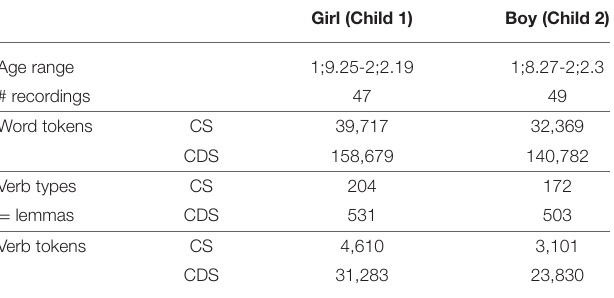
TABLE 4 | The corpus details.